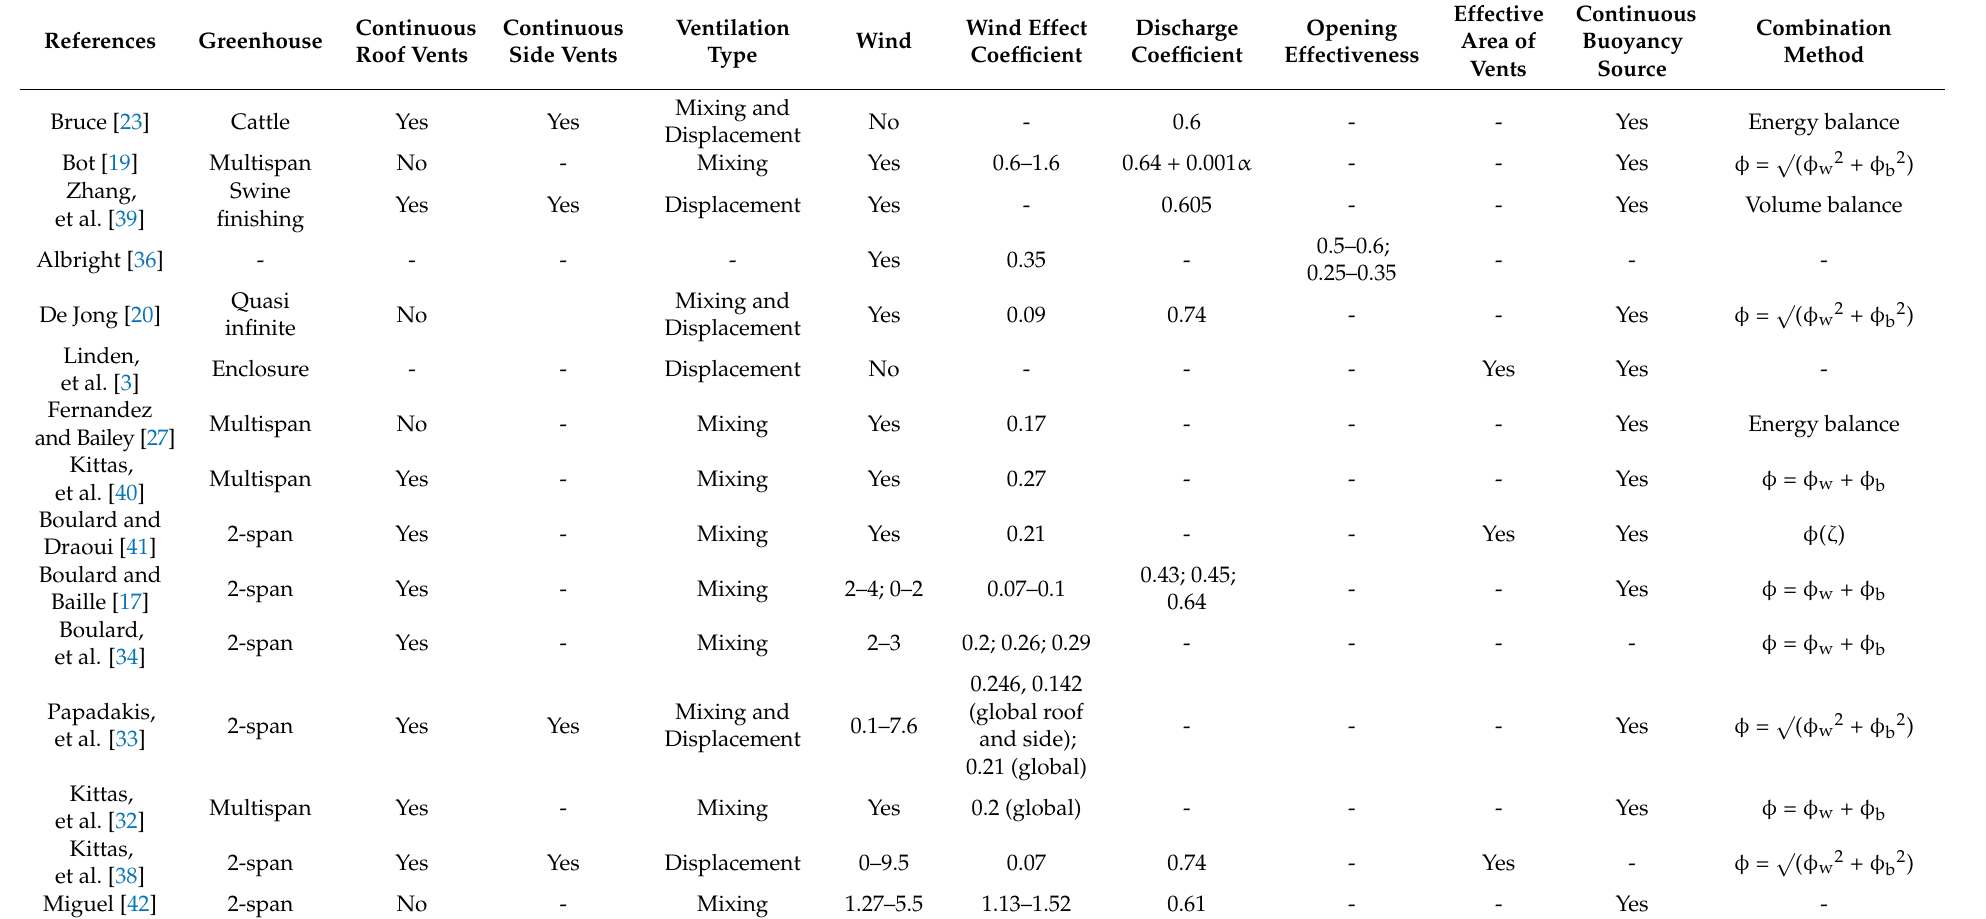
Table 1. The wind effect coefficient given by various greenhouses. Note: “global” means the global wind effect coefficient in the form of C d C w0.5